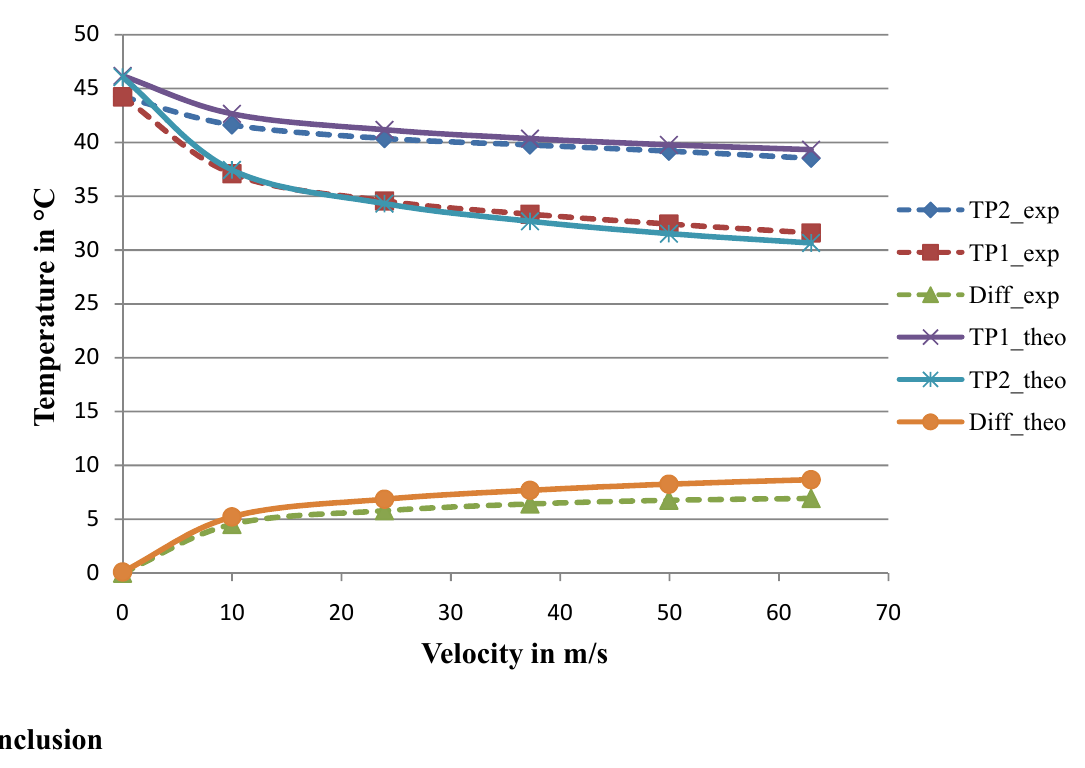
Figure 8. Comparison between model and experimental sensor output signals: up- and downstream thermopiles TP1 and TP2 and their differences as functions of air velocity. Solid lines are for model results and dotted lines are for experimental